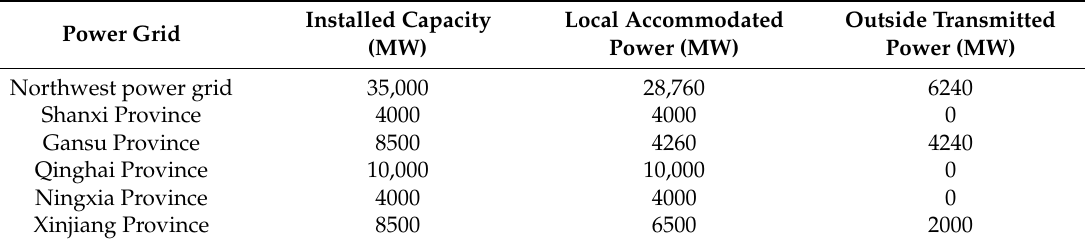
Table 3. Photovoltaic power accommodation in the Northwest power